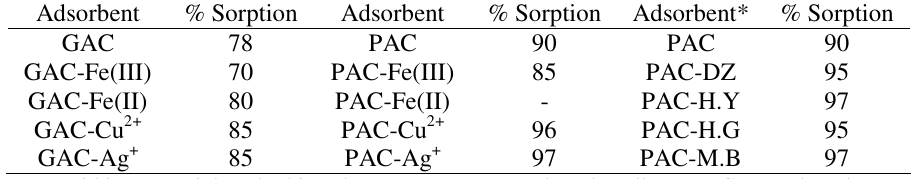
Influence of pretreatment of AC on uptake of As(III) ion Adsorbent % Sorption Adsorbent % Sorption Adsorbent* %